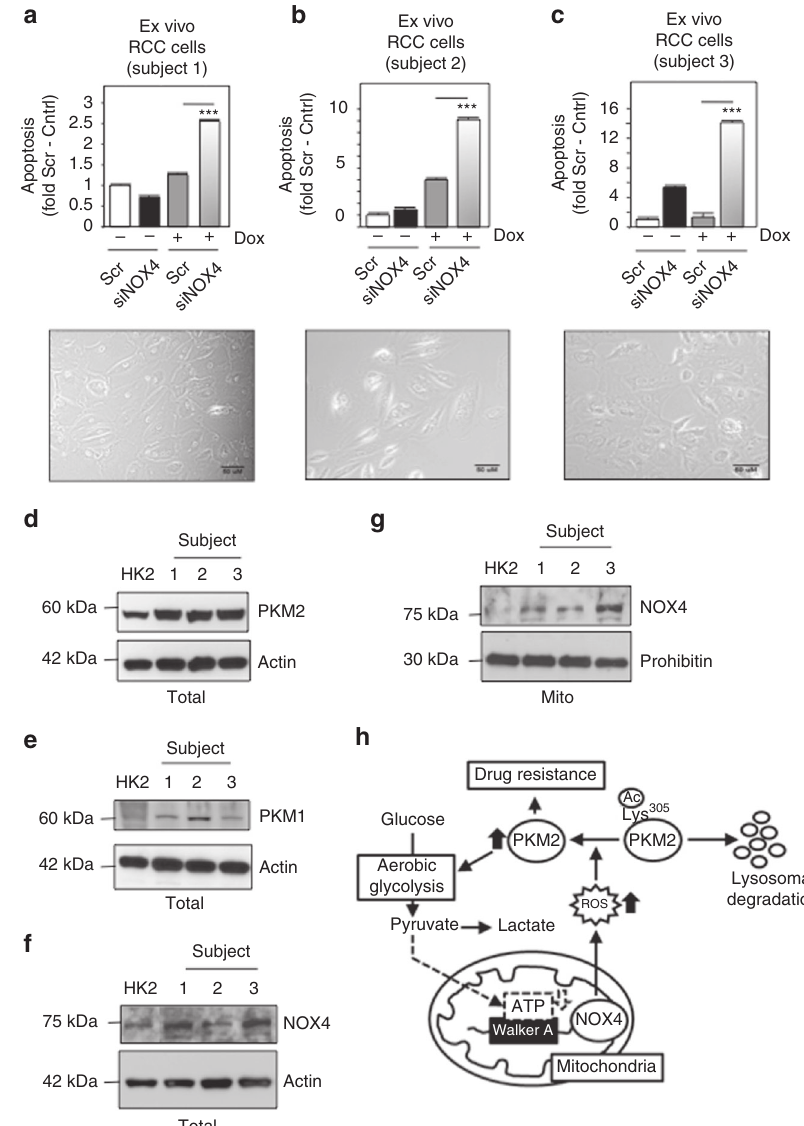
Fig. 9 NOX4 inhibition sensitizes ex vivo human RCC cells to drug-induced cell death. a – c (Upper panel) RCC cells were isolated from human tumor tissue and established in culture. Ex vivo cells were transfected with siRNA to NOX4 (siNOX4) or scrambled control (scr). Subsequently, the cells were treated with doxorubicin and apoptosis was analyzed by Annexin V and fl ow cytometry. (Lower panel) microscopy of the representative human established ex vivo RCC cell lines from a to c , Scale bar: 50 μ M. The results are presented from two independent experiments and expressed as the means using one-way ANOVA with Tukey ’ s post hoc test where ± S.E.M. *** p < 0.001 compared to scr control + doxorubicin. Total cell lysates (Total) or mitochondrial (Mito) fractions were prepared from normal HK2 cells or ex vivo human RCC cell lines and d PKM2, e PKM1, and f , g NOX4 expression was assessed by western blot analysis. h Schematic model of NOX4 ’ s role coupling mitochondrial energetics to cancer drug-resistance through